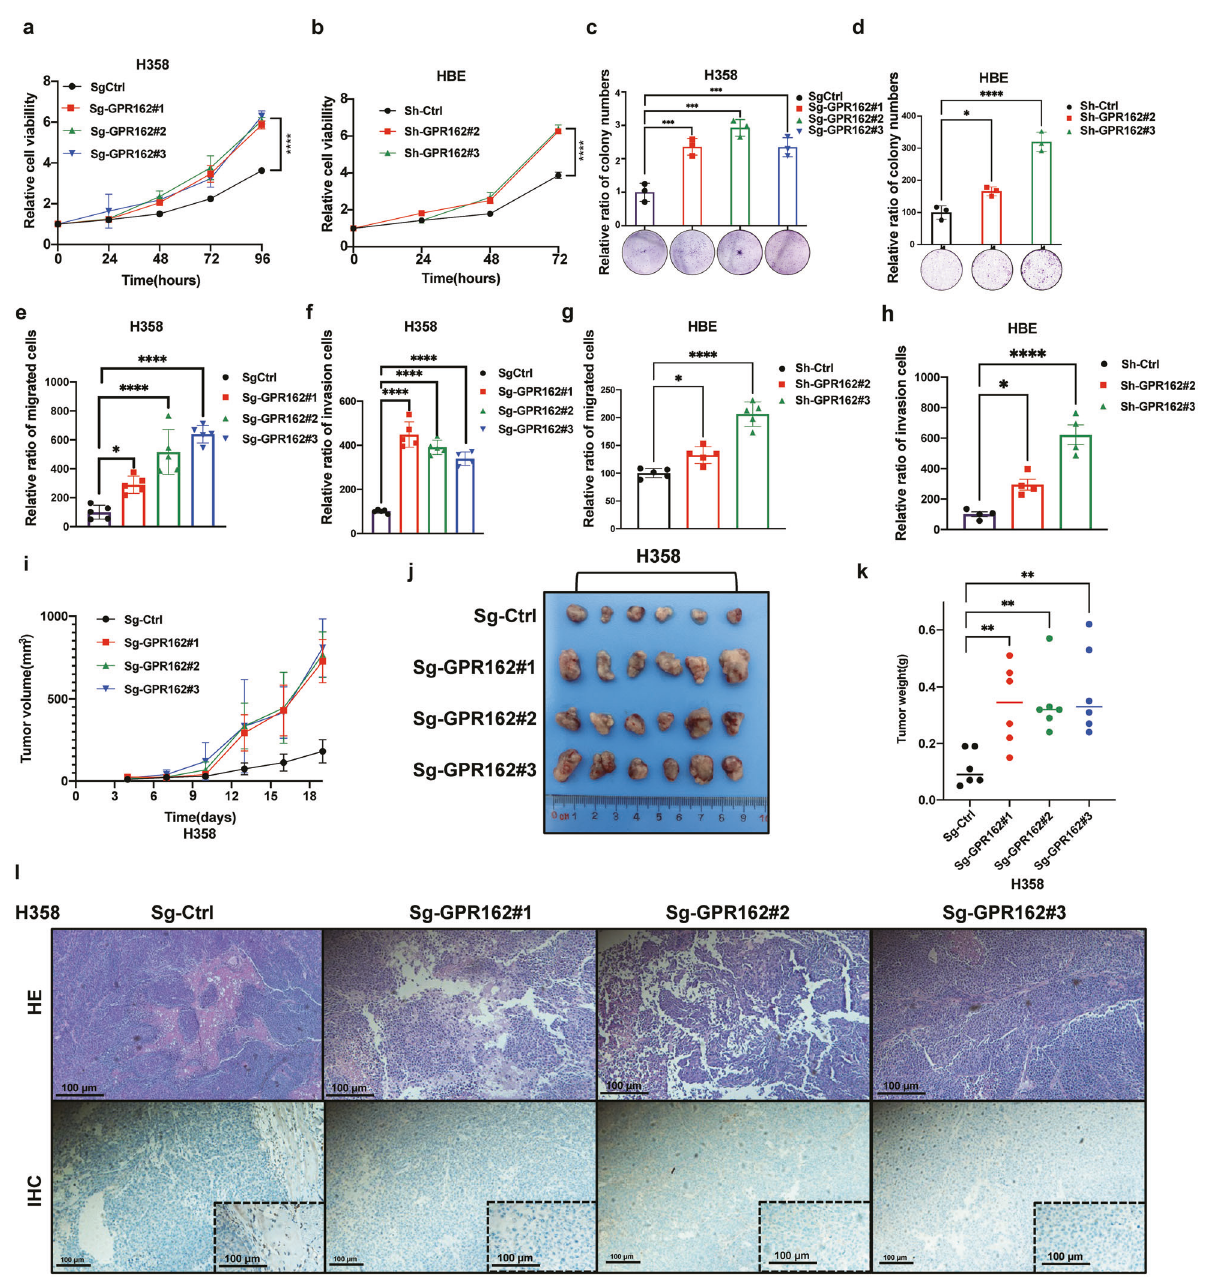
Fig. 7 GPR162 knockout enhances cell proliferation, colony formation, transwell migration and invasion, and tumor development. a , b Cell viability in H358 ( a ) and HBE ( b ) cells with stably knockout and knockdown GPR162 was assessed using the CCK8 assay. c , d A colony formation assay in plates was used to determine the ability of H358 ( c ) and HBE ( d ) cells with stably knockout and knockdown GPR162 to form colonies. e – h GPR162 migration and invasion were detected using a transwell assay in H358 ( e , f ) and HBE ( g , h ) cells with stable deletion and knockdown of GPR162. i – k To assess the capacity of H358 cells with stable GPR162 deletion to produce tumors ( n = 10 mice per group), a tumor growth xenograft model was established. Tumor formation was tracked at the times indicated ( i ), pictures ( j ) and weight ( k ) are shown. l HE and IHC staining of tumor tissue from the xenograft model. (** p < 0.01, *** p < 0.001, **** p <